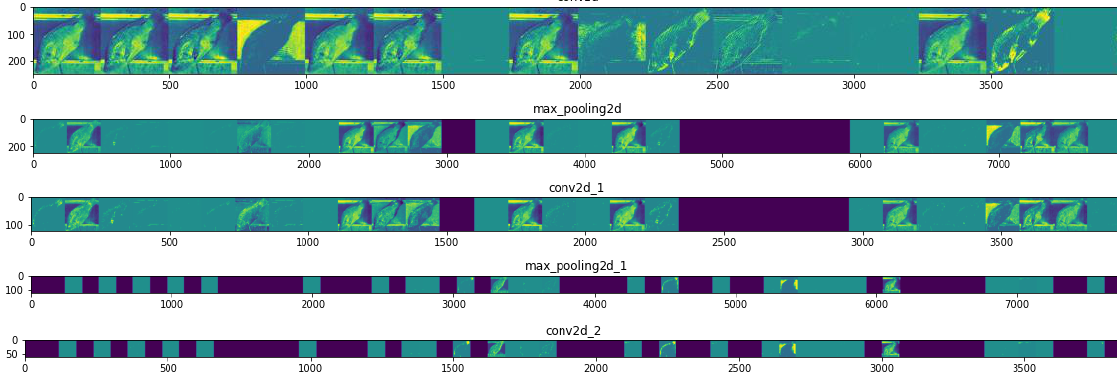
Figure 10. Feature maps visualization with conventional labeling.